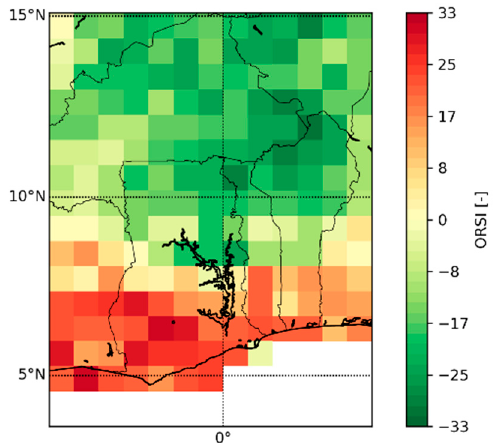
Figure 13. Seasonal forecast of the onset of the rainy season using an index-based method (ORSI) for the year 2001. An early, normal, and late onset of the rainy season is indicated by green (ORSI > 0), yellow (ORSI ~ 0) and red (ORSI < 0) values.